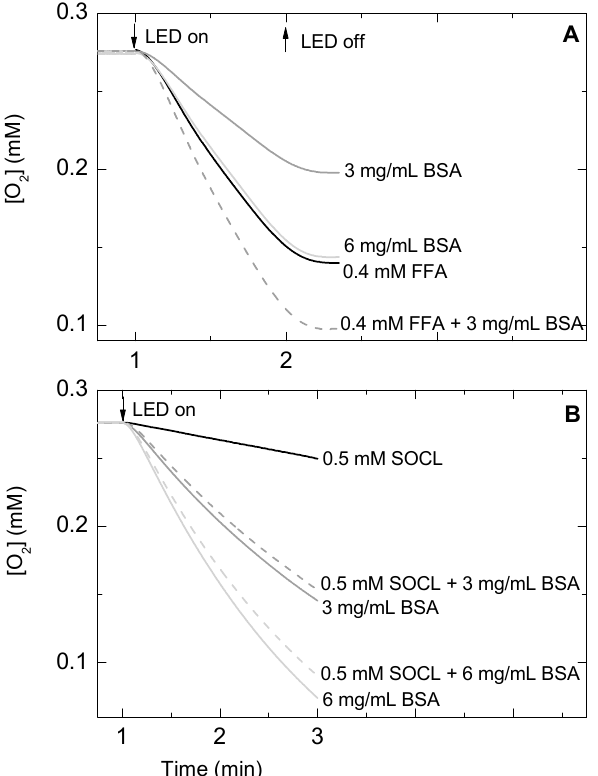
Figure 4. Effect of bovine serum albumin (BSA) concentration on the molecular oxygen uptake of several reaction mixtures containing 2 μ M methylene blue as 1 O 2 photosensitizer and furfuryl alcohol (FFA) at 0 or 0.4 mM ( A ) and Singlet Oxygen Chemiluminescence probe (SOCL) at 0 or 0.5 mM ( B ) as 1 O 2 quenchers in phosphate buffer saline pH 7.4 at 20 ° C. Samples were illuminated with a red light emitting diode (LED) source with an intensity of 2 mE m − 2 s − 1 for 1 min ( A ) or 2 min ( B ). The photo- oxygenation reactions were performed under atmospheric pressure